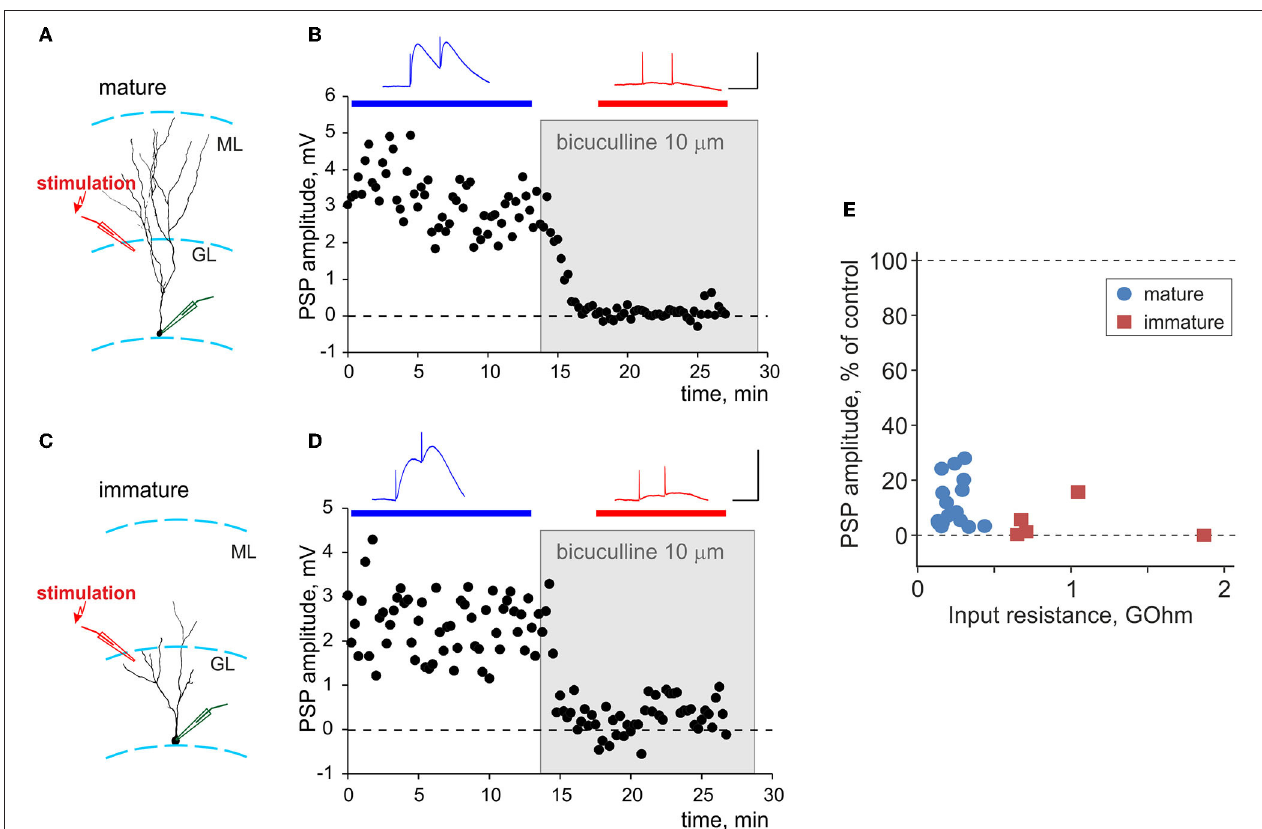
FIGURE 3 | Synaptic responses evoked by local stimulation in the granular layer are GABA-ergic in both mature and immature neurons. (A,C) Schemes of the location of a neurobiotin-labeled mature (A) and immature (C) neurons with the somata in the inner portion of the granule layer (GL), and stimulation electrodes in the outer portion of the granule layer, close to the molecular layer (ML). (B,D) Suppression of synaptic responses in mature (B) and immature (D) neurons by bicuculline. Each time course shows individual PSP amplitudes, with application of 10 µ M bicuculline indicated by a gray rectangle. PSPs above the plots are averages over the periods indicated by the horizontal bars of respective color, before and after bicuculline application. Scale bars: 50ms, 3mV. (E) Averaged amplitude of PSP responses after application of bicuculline, in percentage of control, plotted against input resistance for n = 16 mature (blue circle symbols) and n = 5 immature (dark red square symbols)